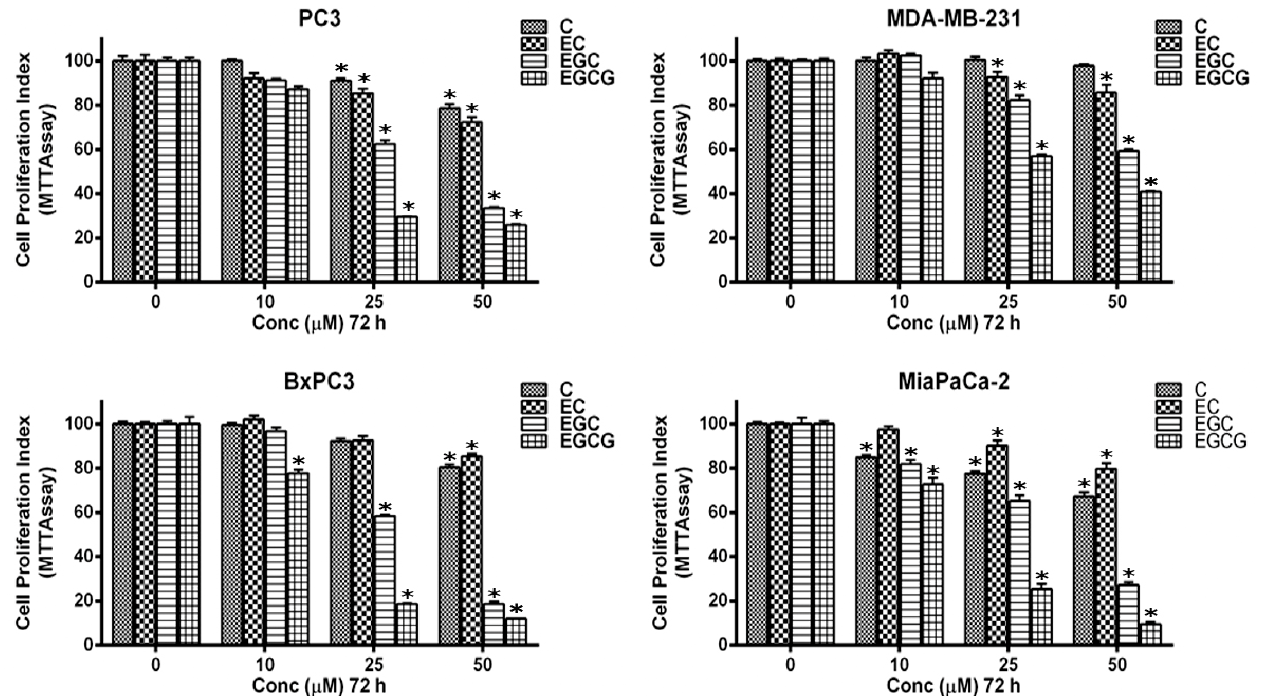
Figure 2. Effect of C, EC, EGC, and EGCG on cell proliferation in various cancer cell lines as detected by MTT assay. Cells from PC3, MDA-MB-231, BxPC3, and MiaPaCa-2 cancer cell lines were incubated with indicated concentrations of C, EC, EGC, and EGCG for 72 h. The effect on cell proliferation was detected by performing an MTT assay, as described in the Materials and Methods section. All results are expressed as percentage of control ± S.E. of triplicate determinations. * p < 0.01 when compared to respective untreated